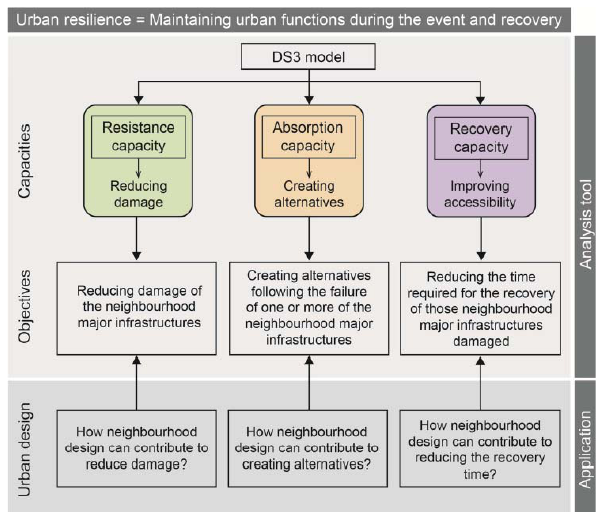
364 Figure 7 : Application of conceptual Spatial Decision Support System model to the 365 Figure 7. Application of conceptual Spatial Decision Support System model to the neighbor- Figure 7. Application of conceptual Spatial Decision Support Sys- neighborhood level (Balsells Mondéjar et al. 2013) 366 hood level (Balsells Mondéjar et al., 2013). tem model to the neighbourhood level (Balsells Mondéjar et al.,